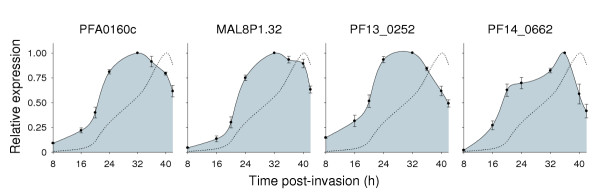
Stage-dependent gene expression of the four P. falciparum members of the equilibrative nucleoside transporter family, throughout the intraerythrocytic cycle of the parasite. The PF13_0252 gene encodes the P. falciparum nucleoside transporter, PfENT1 [62,63]. The analysis was carried out as described in the legend to Figure 4.